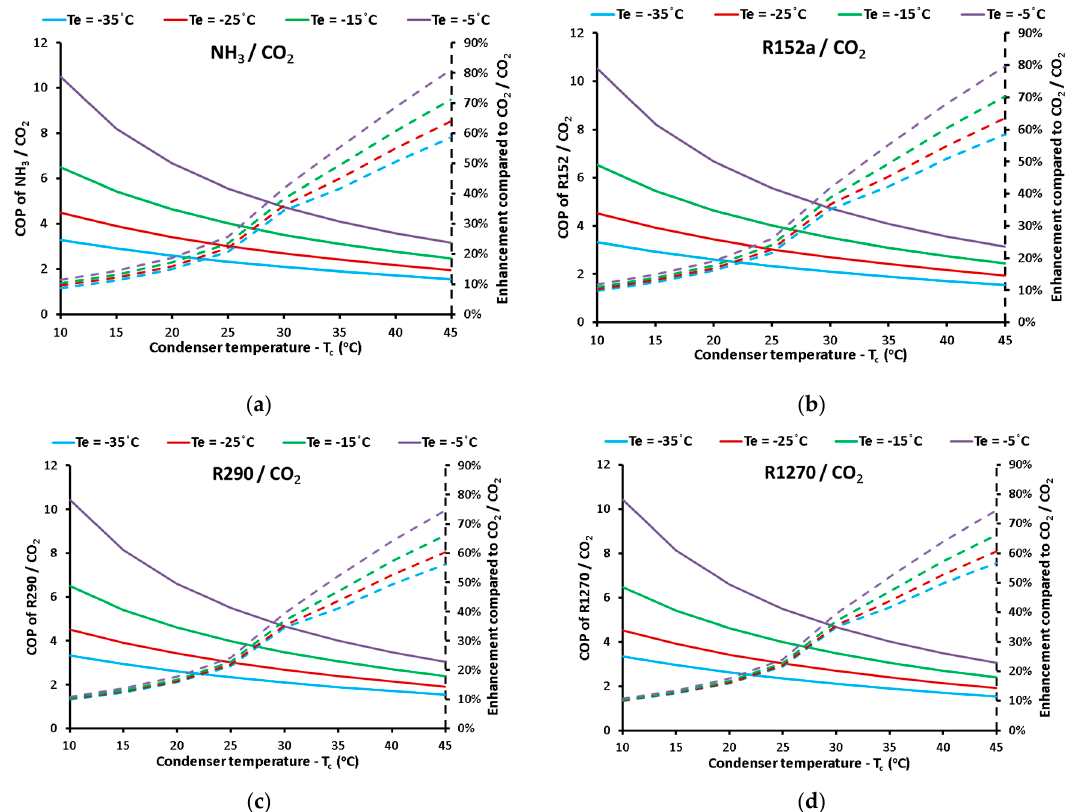
Figure 6. COP and the enhancements compared to CO 2 /CO 2 for the systems ( a ) NH 3 /CO 2 ; ( b ) R152a/CO 2 ; ( c ) R290/CO 2 ; ( d ) R1270/CO 2 .